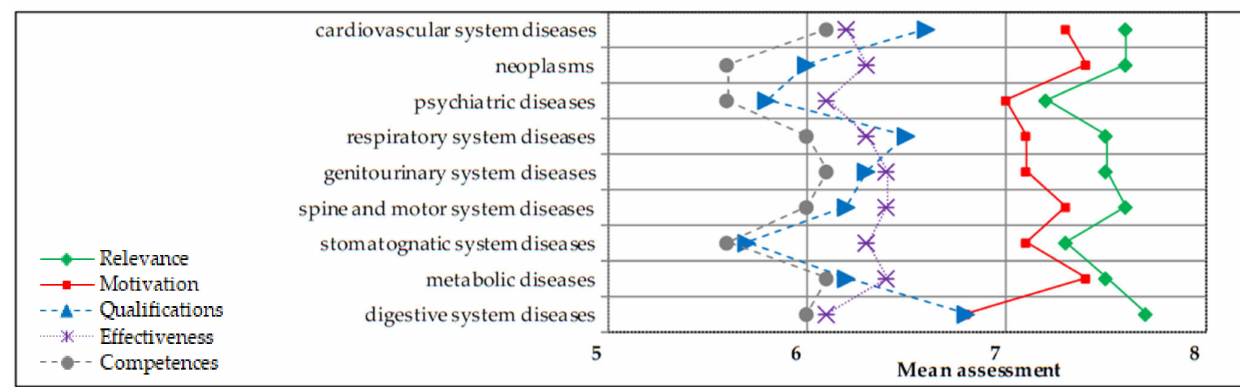
Figure 2. Pharmacy students’ mean assessment of qualifications, competences, relevance, motivation and effectiveness in health promotion— items in disease prevention (N = 206). Scale 1–10 where: 1—very low, 10—very high.